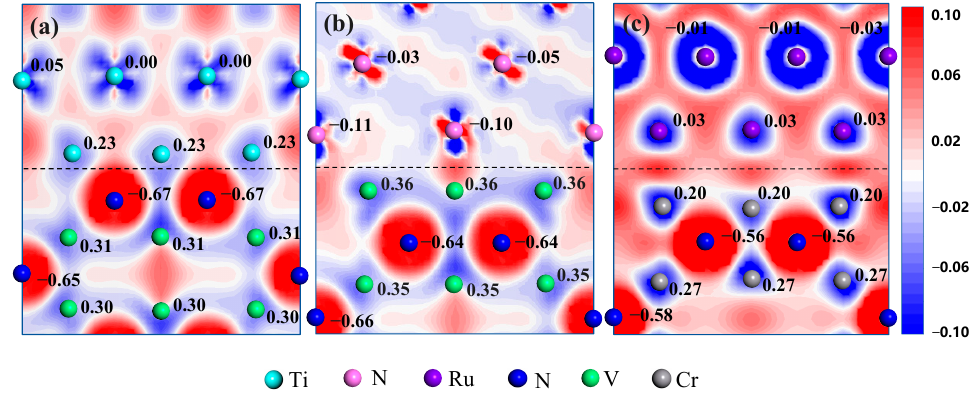
Figure 8. Charge density difference plots of ( a ) Ti(0001)/V 2 N(0001)-2N(hol), ( b ) Ni(111)/V 2 N(0001)- V, and ( c ) Ru(0001)/Cr 2 N(0001)-Cr interface models. Mulliken charge (unit: e) is labeled beside the atoms. The dashed lines represent the positions of the interfaces.